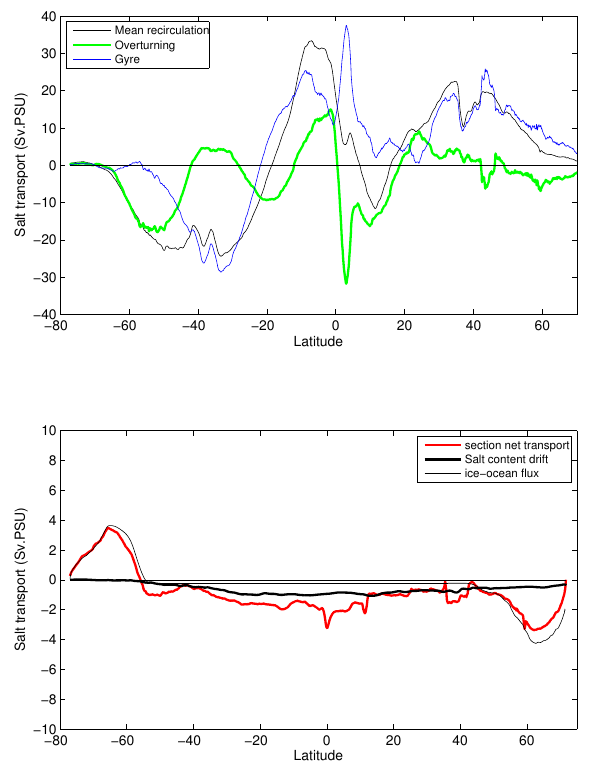
Fig. 5. Further analysis of the meridional transport of salt in the ORCA12 simulation. Top panel: transport by the time–mean re- circulation velocity (thin black curve, same as Fig. 4), and its two components: the “overturning” (transport by the zonally aver- aged, depth-dependent velocity) and the “gyre” component. Bottom panel: contributions from the model drift and the ice–ocean flux which could explain the non-zero total salt transport (the red curve, same as in Fig.